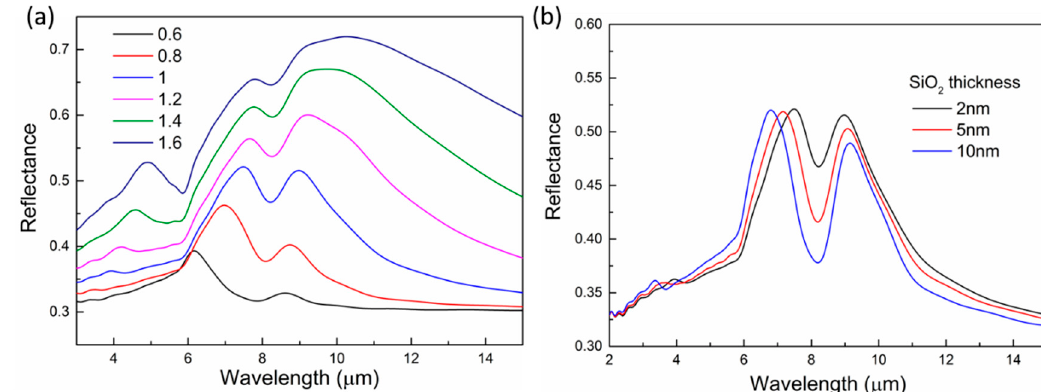
Figure 5. Sensing of the surface phonon polariton from SiO 2 with ITO nanodisks. ( a ) Reflectance spectra of the ITO disk arrays with a 2-nm thick SiO 2 layer underneath the arrays. The diameter of the disks is changed to tune the plasmon resonances and study the coupling between the plasmon mode and the SiO 2 vibration. ( b ) Reflectance spectra of the disk array (P = 2 μ m and D = 1 μ m) with different SiO 2 layer thickness.